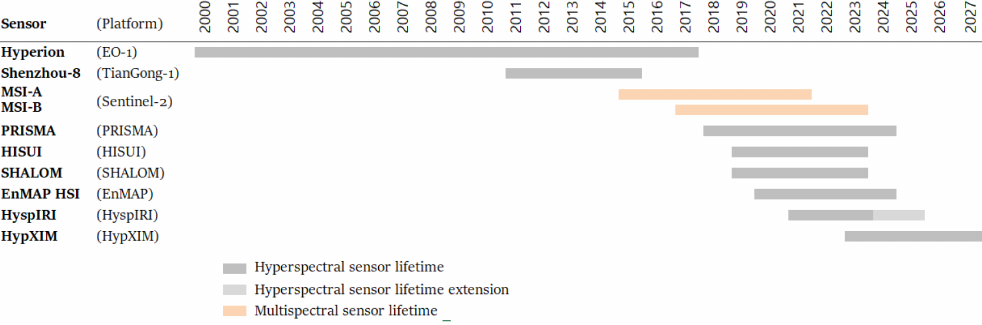
Figure 1. Lifetime of the main multispectral imagers sensors and the hyperspectral-image (HSI) sensor in past and plan